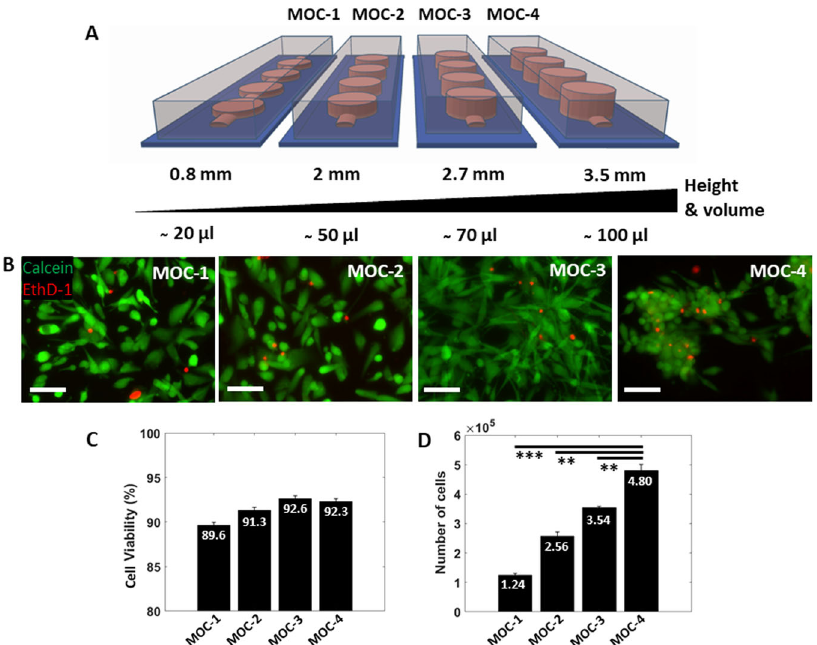
Fig. 2 MOC biocompatibility. A Sketch showing the 4 different MOCs in height and volume, namely 0.8, 2, 2.7, 3.5 mm corresponding to ~20, 50, 70 and 100 μ L. B Live cell imaging of A-172 glioblastoma cells seeded within the respective MOC devices for 48 h. Cells were stained with the Live/Dead stain where cells shown in green (Calcein AM) indicate live cells and those shown in red (EthD-1) indicate dead cells. C Graph indicates the percent of cells viable per MOC. D Graph shows the absolute number of cells present in each MOC following 48 h of growth. Scale bars, 50 µm. Data are shown as the mean ± SEM ( n = 3). Asterisks are reported for cases with statistical signi fi cance: ** MOC-4 Vs MOC-3: p = 0.004, MOC-4 Vs MOC-2: p = 0.009, *** MOC-4 Vs MOC-1: p = 0.001. The statistical analysis of the data was performed using one-way analysis of variance (ANOVA) with Turkey ’ s test for multiple